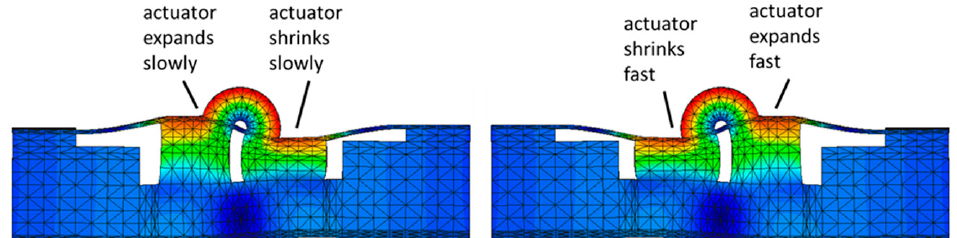
Figure 2. The deformed state of the actuators in the friction coupler resulted in friction coupler movement. Note that the intersection point of the actuators and the friction coupler is a hinge point. Dark blue color represents small displacements while red color represents larger displacement re- gions.